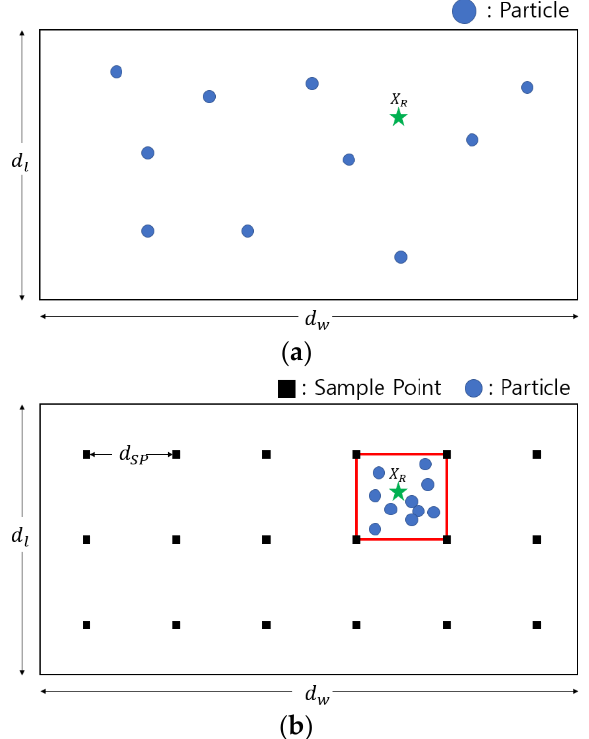
Figure 4. Initial particle distribution of PSO: ( a ) non-limited search region, ( b ) limited search re- gion.